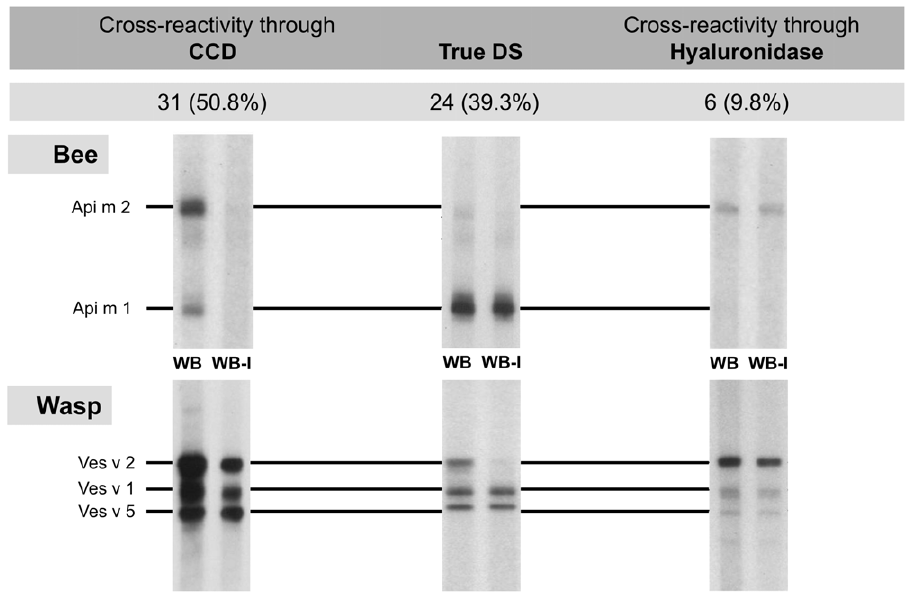
Figure 3. Frequency of typical IgE patterns obtained by western blot inhibition in CAP double sensitized patients. CCD: cross-reactive carbohydrate determinants, True DS: true double sensitization, WB: western blot, WB-I (western blot inhibition): To discriminate between IgE specific for peptide or carbohydrate epitopes, antibody binding to CCDs was inhibited by preincubating sera with MUXF-BSA. Among these patients the majority of DS was CCD-dependent. DS due to protein components of hyaluronidases played a minor role. n=61.